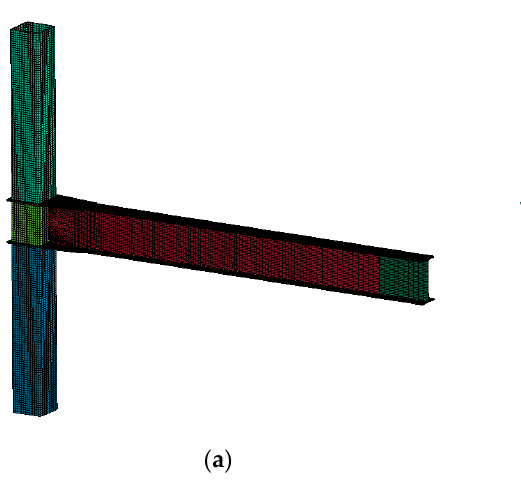
Figure 7. Finite element models for verification and validation. ( a ) LS-DYNA model; ( b ) ABAQUS model.